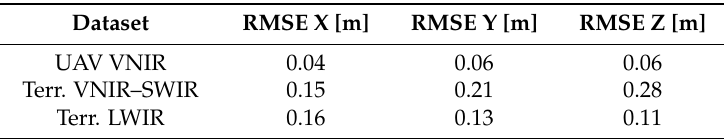
Table 7. Georeferencing accuracies. Abbreviations: